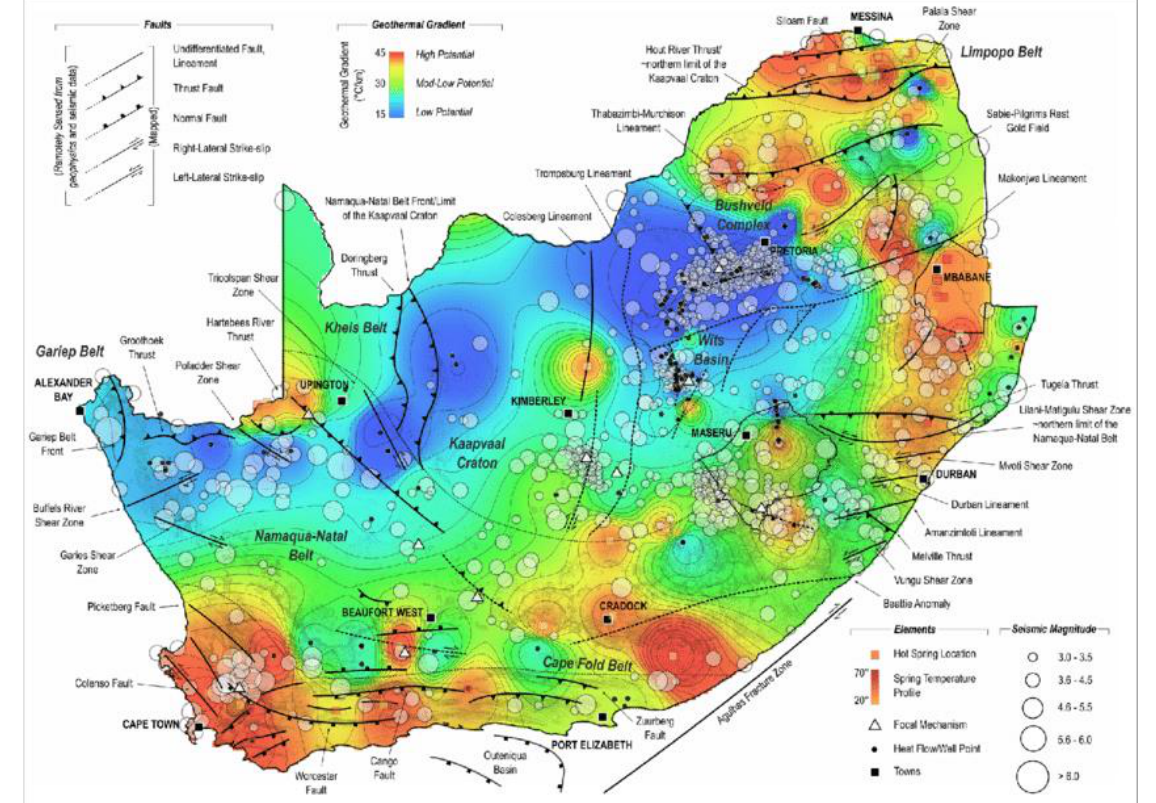
Figure 4. Areas with the potential of geothermal energy Adopted from